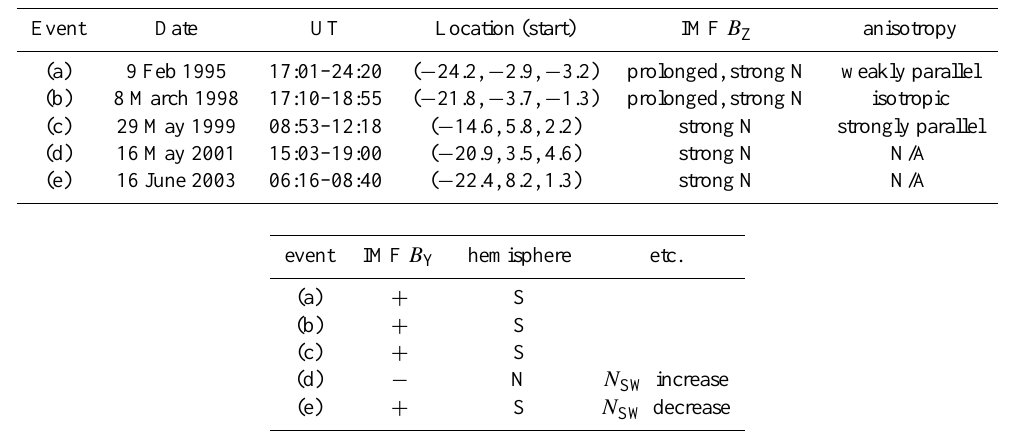
Table 1. Two-component proton events found in the midnight region. In the column of the anisotropy, “N/A” is the abbreviation for “not available”. As for hemispheres, S and N represents the Southern and Northern Hemispheres, respectively. The hemisphere where the two-component protons were initially observed is focused on.